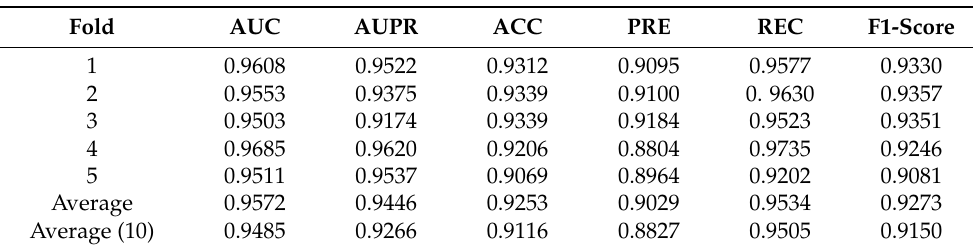
Table 4. Results of FFCV on DATA achieved by GGCDA.